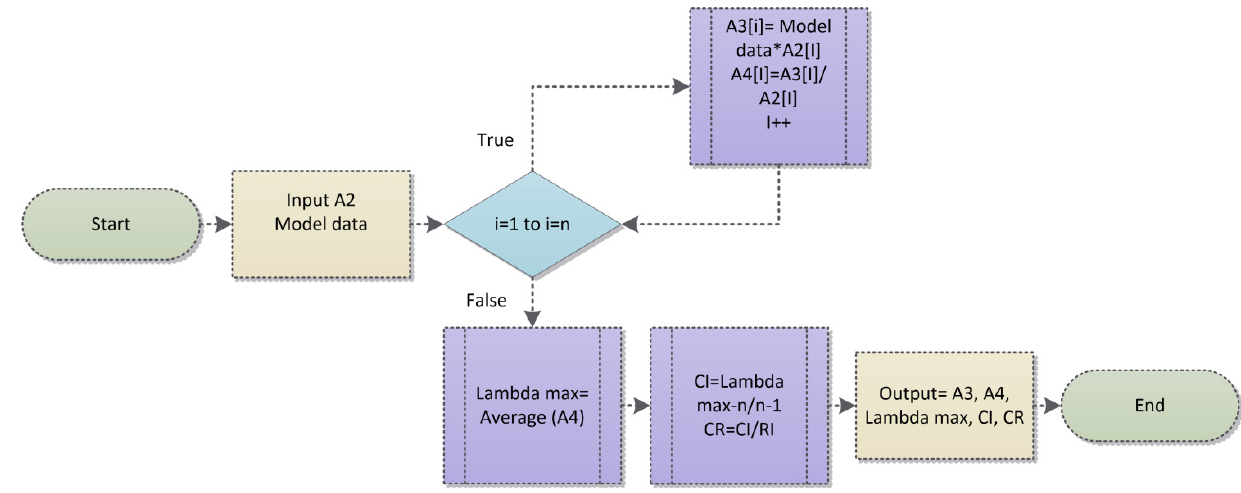
Figure 6. Flowchart of Algorithm 2 for calculating CR. Table 4. Calculating consistency ratios.